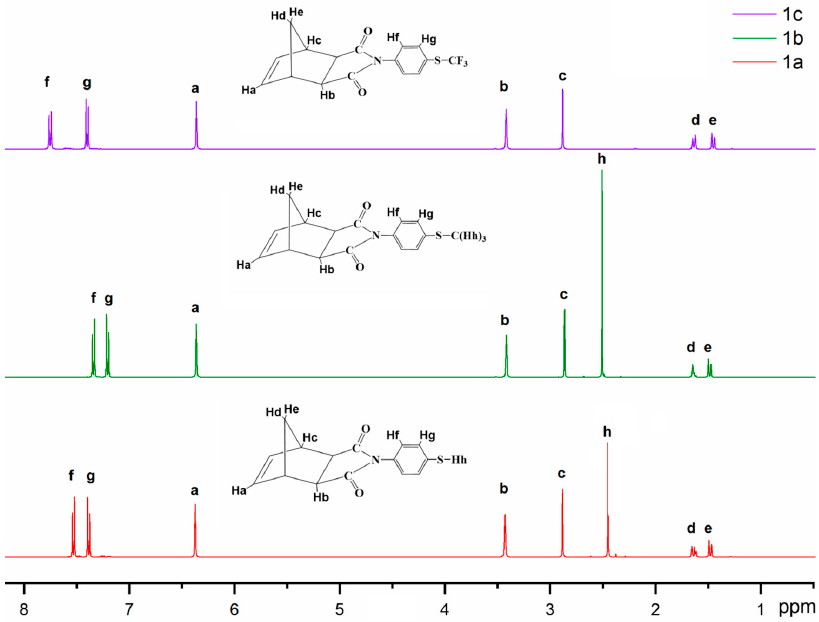
Figure 3. 1 H ‐ NMR spectra of the thiol ‐ functionalized norbornene dicarboximide monomers. Figure 3. 1 H-NMR spectra of the thiol-functionalized norbornene dicarboximide monomers.